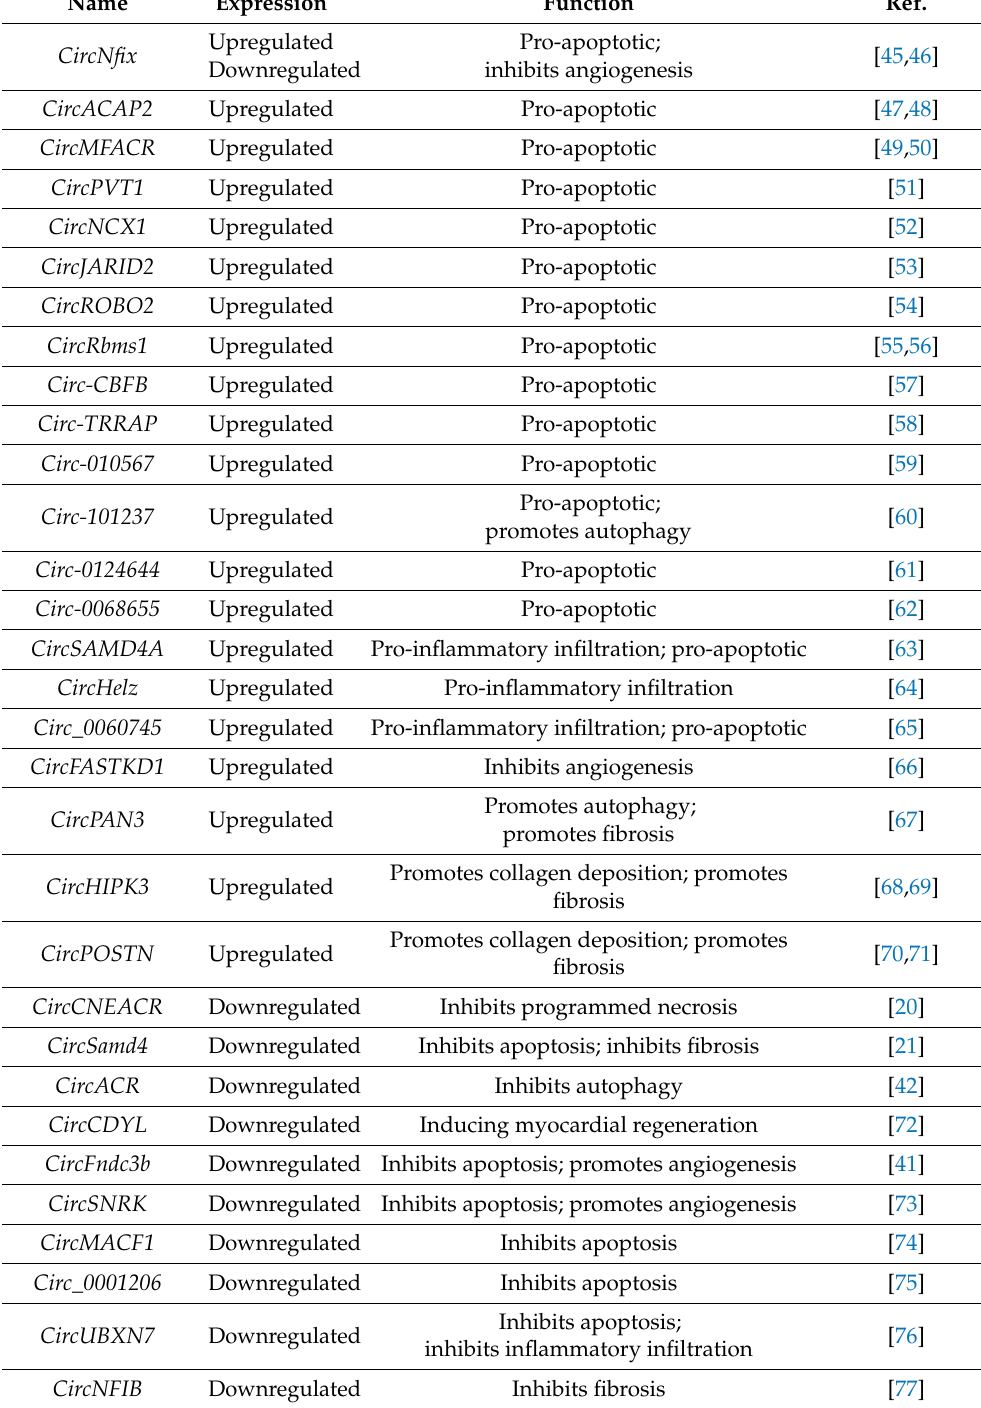
Table 1. Specific and multiple roles of circular RNA in the pathogenesis of myocardial infarction, including cardiomyocyte death, inflammatory infiltration, and fibrosis. They are described in detail in the